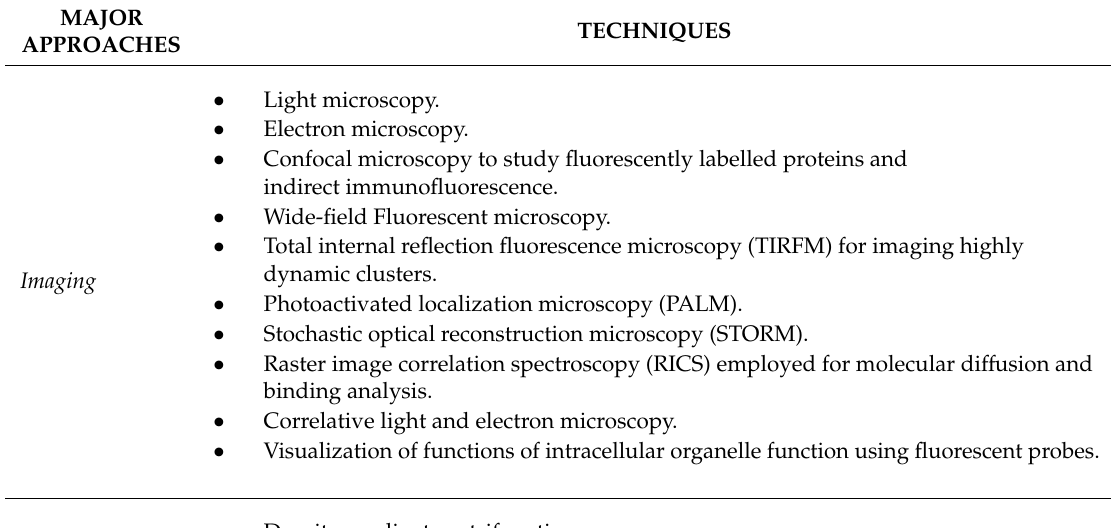
Table 3. Major approaches and techniques used in cell signaling